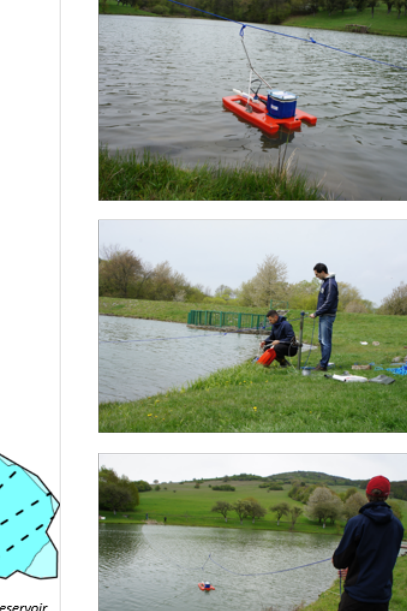
Figure 3. Elevation-capacity curve of the Vrbovce SWR.